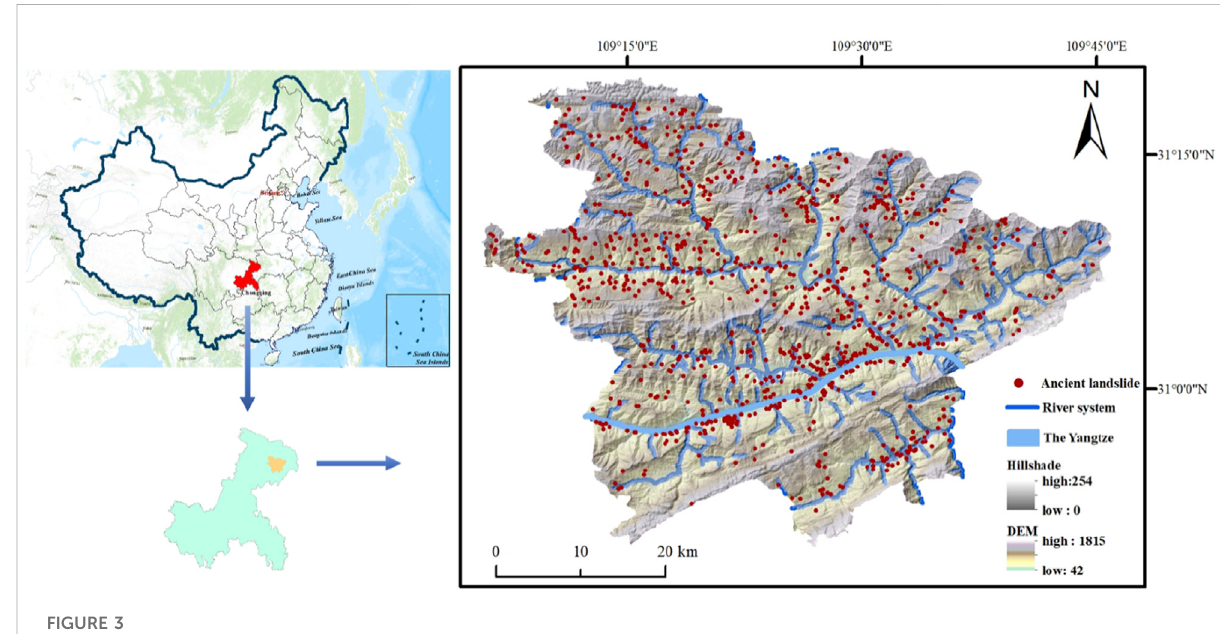
FIGURE 3 Location of the study